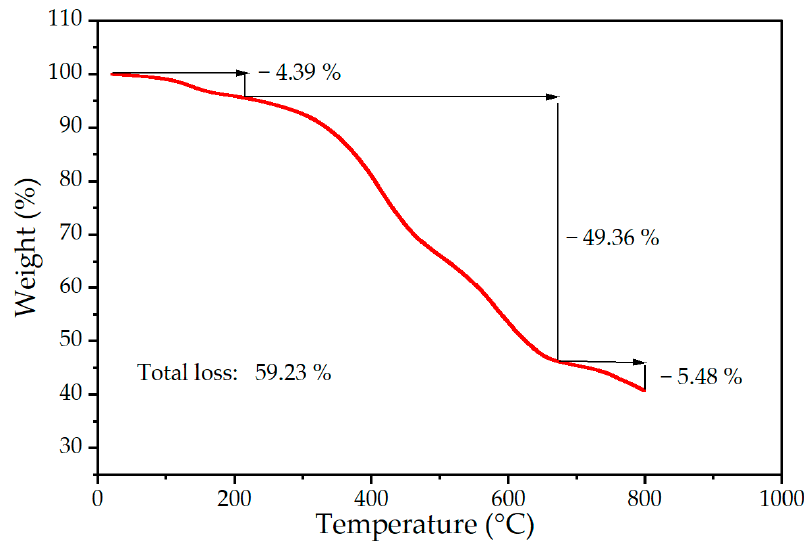
Figure 5. Thermogravimetric analysis for the determination of nanoparticle weight in the silicone matrix.